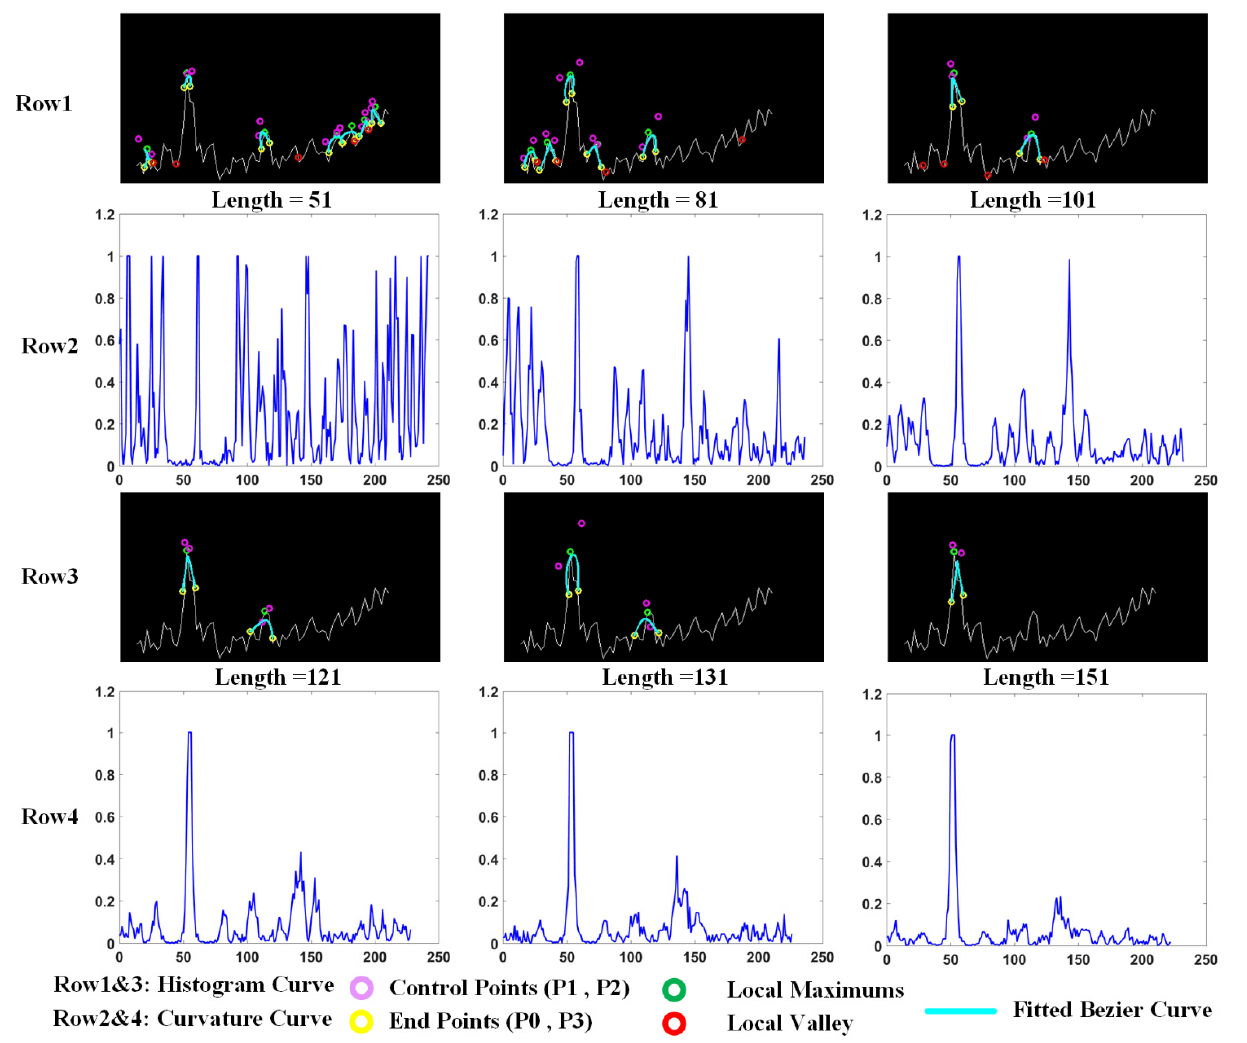
Figure 10. Bezier curve fitting and curvature results using different sub curve length.